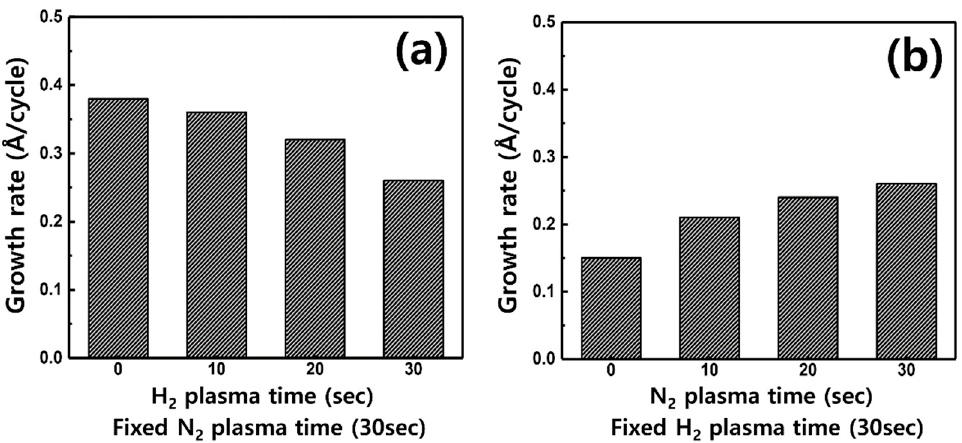
Figure 7. ( a ) The growth rate as a function of H 2 plasma exposure time (N 2 plasma exposure time fixed at 30 s); ( b ) The growth rate as a function of N 2 plasma exposure time (H 2 plasma exposure time fixed at 30 s).